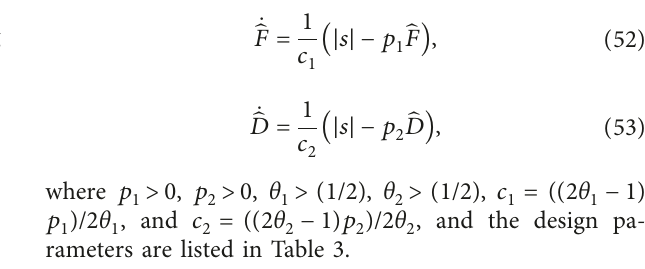
Figure 10: Time response of attitude in M2 under different initial